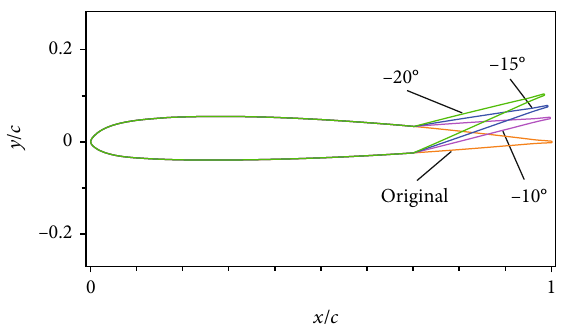
Figure 26: Schematic of airfoil shapes at di ff erent minimum de fl ection angles of the TEF.